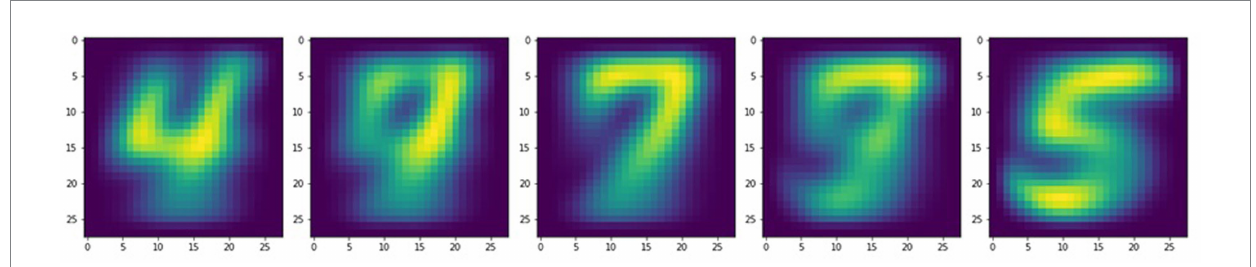
FIGURE 7 Visualizations of the memristive neural network demonstrating lifelong self-learning through successful training on different numerical digits